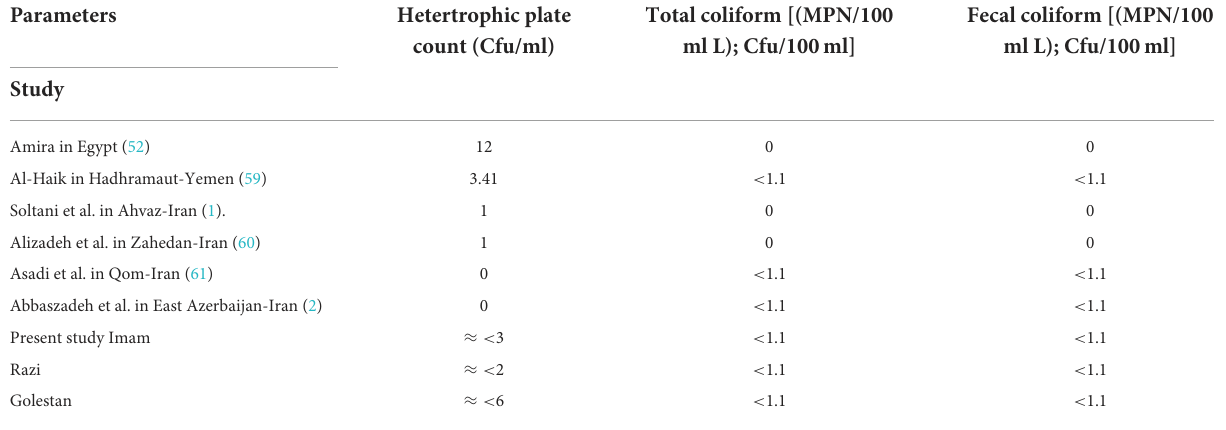
TABLE 1 The microbiological quality of water used for hemodialysis instruments and comparison of various studies.